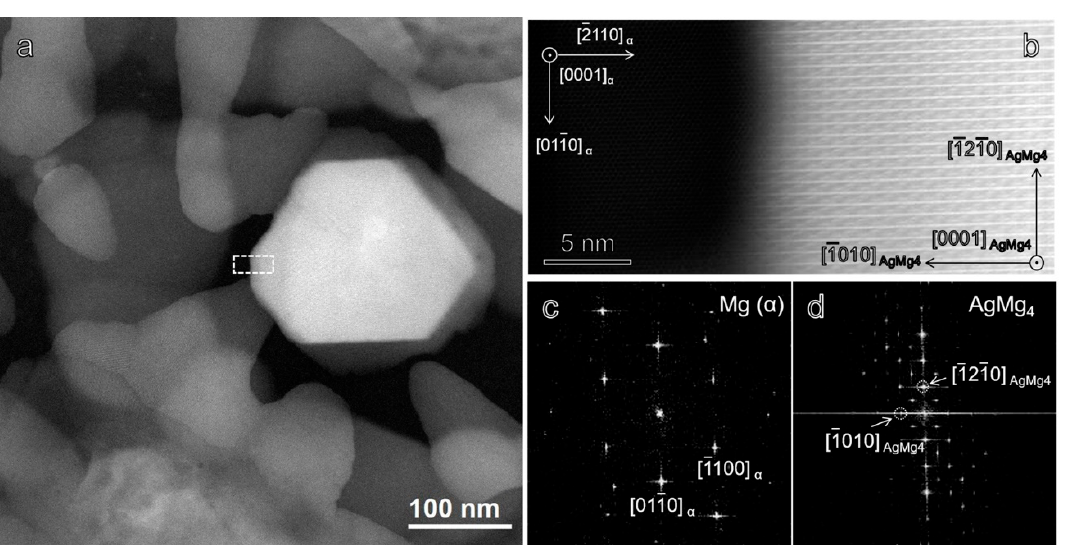
Figure 10. ( a ) HAADF ‐ STEM image recorded along the [0001] ɑ direction. ( b ) Enlargement of the marked region in (a). FFT patterns generated from ( c ) α‐ Mg matrix and ( d ) AgMg 4 phase showing their orientation